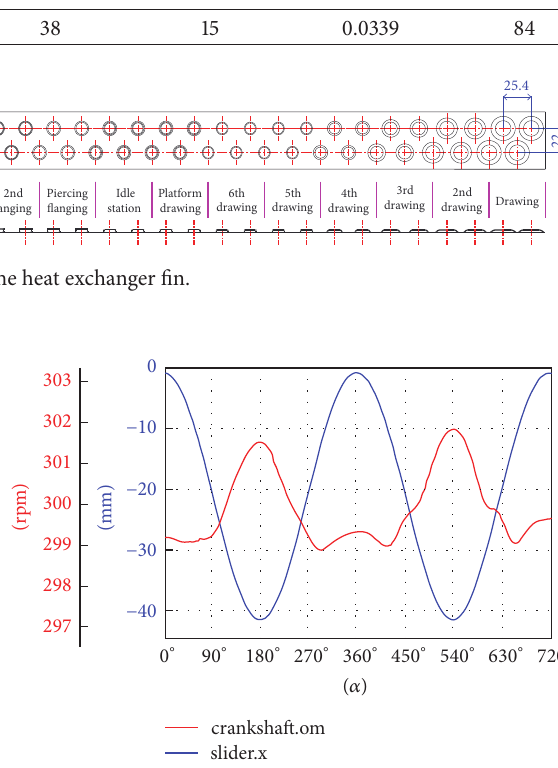
Figure10:Curvesofthesimulatedrotationalspeedofthecrankshaft and displacement of the